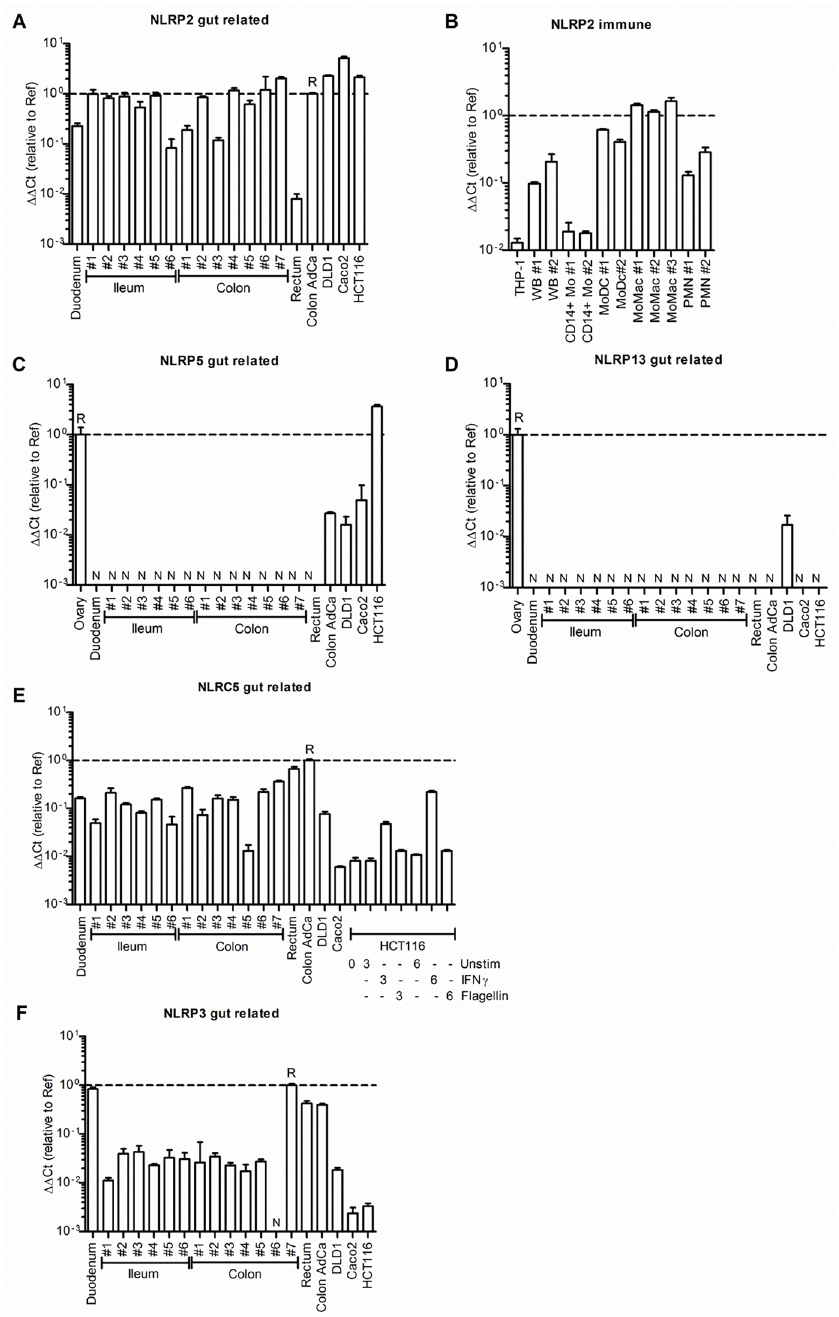
Fig 2. Expression of selected CRC-associated NLRs in immune cells, primary tissue samples or CRC cell lines. mRNA expression of NLRP2 (A,B), NLRP5 (C), NLRP13 (D), NLRC5 (E) and NLRP3 (F) was determined relative to the housekeeper TBP by performing triplicate (means +SD show) qPCR using TaqMan gene-specific primers and probes on the indicated samples (see Methods). In the case of (E) HCT cells were treated with 1000 U/ml IFN γ or 50 ng/ml S. typhimurium Flagellin for 3 or 6 hours as indicated. TBP-relative Δ Ct values were normalized to a reference sample (labelled R, ΔΔ Ct method). N denotes samples in which no expression was detectable above Ct within 40 cycles.